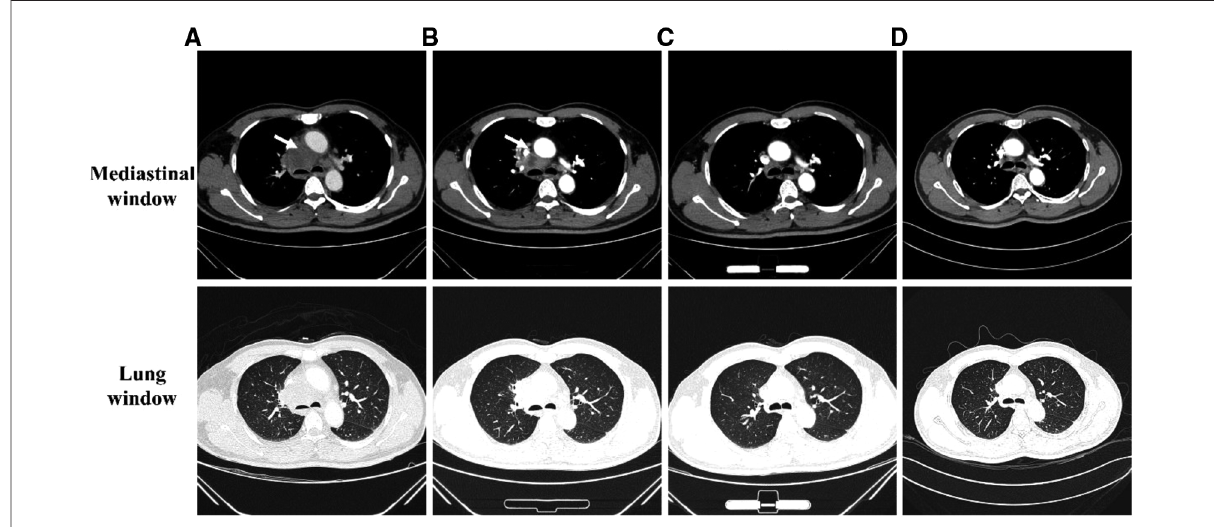
FIGURE 1 The dynamic changes in enhanced chest CT images at different time points. Mediastinal (top) and lung window (bottom). ( A ) At admission, Chest CT showed a mediastinal mass measuring 7.76×4.55 cm (arrow). ( B ) During discharge, Chest CT showed a decrease in the size of mediastinal mass to 5.53×4.51 cm (arrow). ( C ) After six months of treatment, Chest CT showed obvious absorbance of the mediastinal lesions. ( D ) One and a half years follow-up Chest CT showed obvious absorbance of the mediastinal